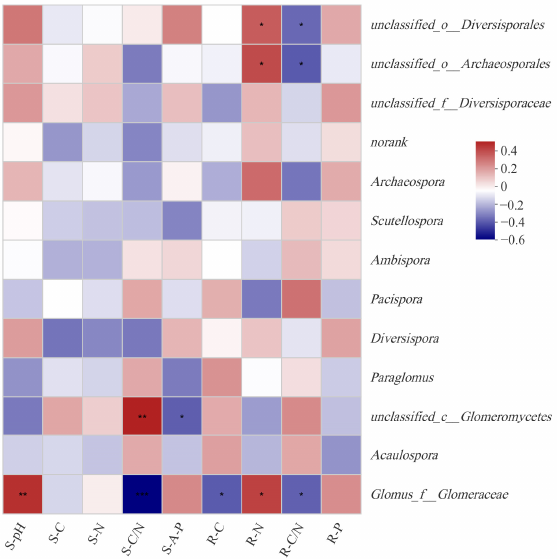
Figure 5. Influence of environmental factors on AMF genus. Note: *, **, *** indicate significant correlation at p < 0.05, p < 0.01, p < 0.001 confidence level, respectively.